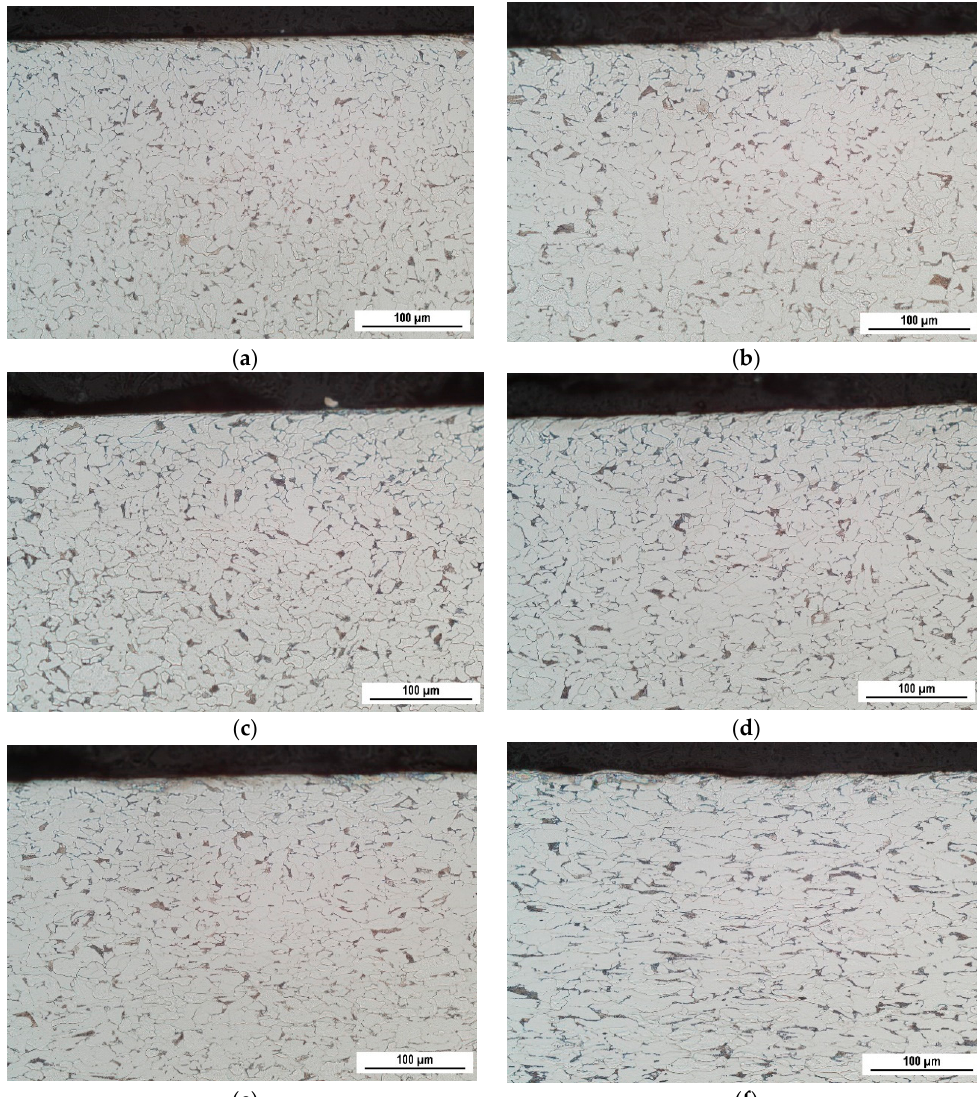
Figure 6. Optical images for the different ε . ( a ) ε = 5%; ( b ) ε = 15%; ( c ) ε = 20%; ( d ) ε = 30%; ( e ) ε = 35%; ( f ) ε = 40%.